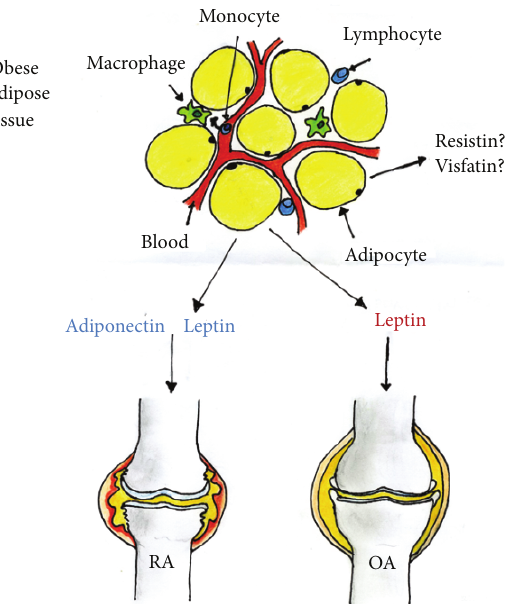
Figure 1: The white adipose tissue (WAT) is considered a major endocrine organ through the capability of secreting adipocytokines. In obese individuals, WAT hosts many immune cell populations interacting with adipocytes. Obesity is a risk factor for both rheumatoid arthritis (RA) and osteoarthritis (OA), and it is likely that some adipocytokines are involved in the pathogenesis of these two diseases. In RA, serum adiponectin levels were associated with radiographic damage and decreased as visceral fat area increased; leptin levels were associated with insulin resistance. In OA, leptin levels were associated with increased levels of bone formation biomarkers and erosive disease, and a positive correlation with the body mass index was also observed. These adipocytokines may be involved in the increased cardiovascular risk observed in RA and OA patients. Conversely, the role of resistin and visfatin is still